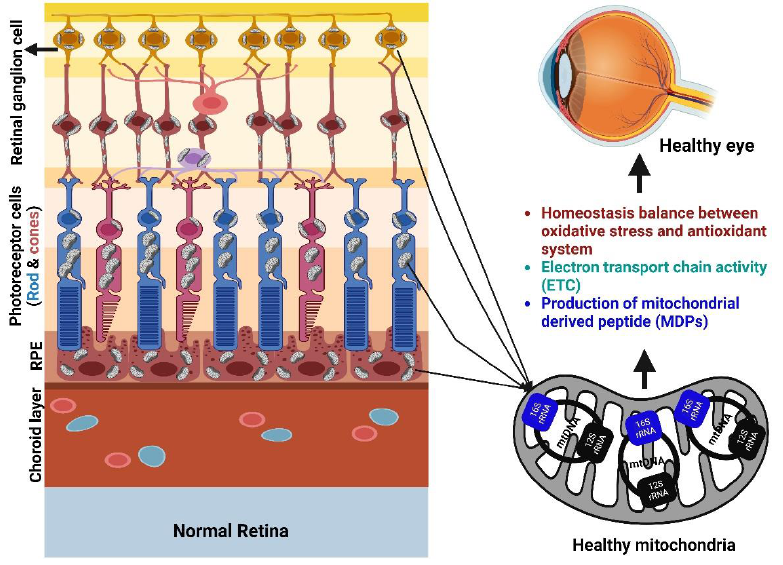
Figure 1. Mitochondria ’ s biological role in the retina of a healthy eye . Created with Biorender.com